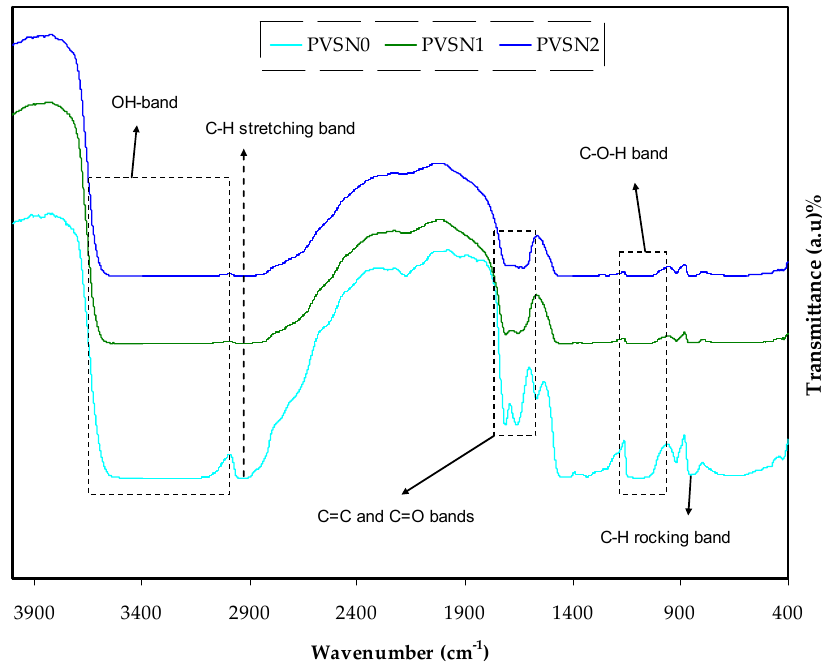
Figure 4. FTIR spectra for pure PVA and loaded films.